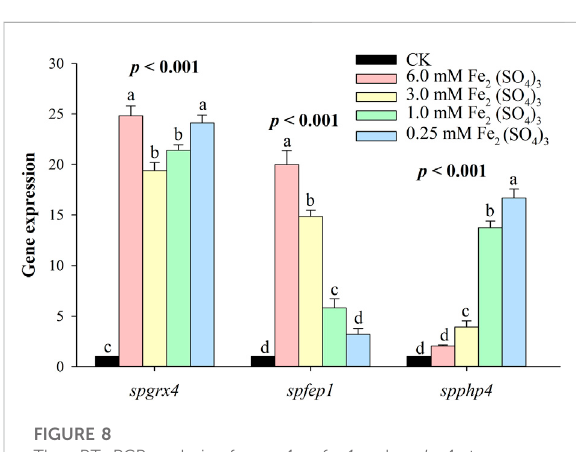
FIGURE 8 The qRT – PCR analysis of spgrx4, spfep1 and spphp4 at varying concentrations of ferrous. The β -actin gene served as the internal control. Error bars were used to depict the standard error of the three scienti fi c repeats. The various letters represent statistically signi fi cant differences ( p < 0.05) between the treatment and the control